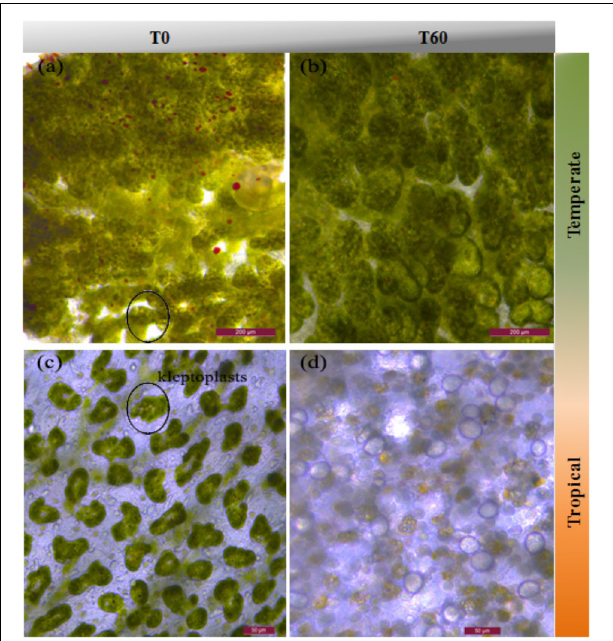
FIGURE 2 | Light micrographs of the termini of the digestive diverticula tubules of E. viridis (a,b) and E. crispata . (a) Kleptoplasts of E. viridis at T0 (Control, 18 ◦ C, pH8.0). Kleptoplasts are packed tightly in the tubule cells and ramify throughout the body. (b) Kleptoplasts of E. viridis at T60 (Acidification + Warming, 22 ◦ C, pH7.6); (c) kleptoplasts of E. crispata at T0 (Control, 26 ◦ C, pH8.0). The main area is traversed by small digestive diverticula; kleptoplasts are located along the length of the tubules as well in the tip of the tubule (black circle) (Curtis, 2006). (d) Bleaching of E. crispata kleptoplasts at T60 – (Acidification + Warming, 30 ◦ C, pH7.6). Scale bar: (a,b) 200 µ m and (c,d) 50 µ m.